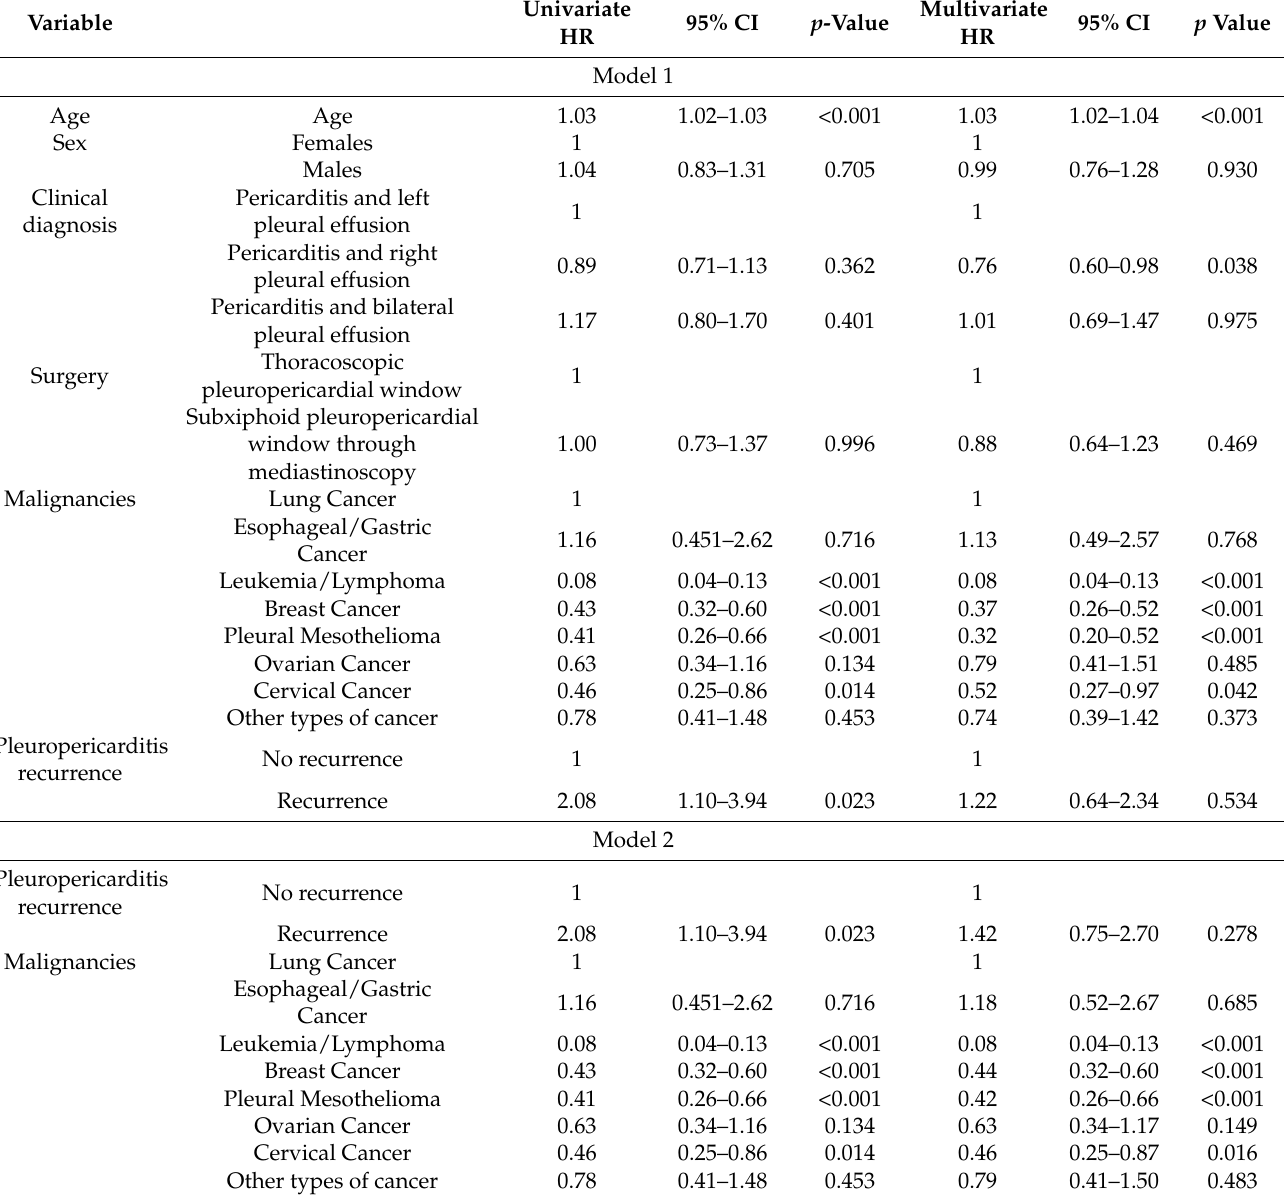
Table 5. Cox proportional hazard regression analysis for mortality among patients with